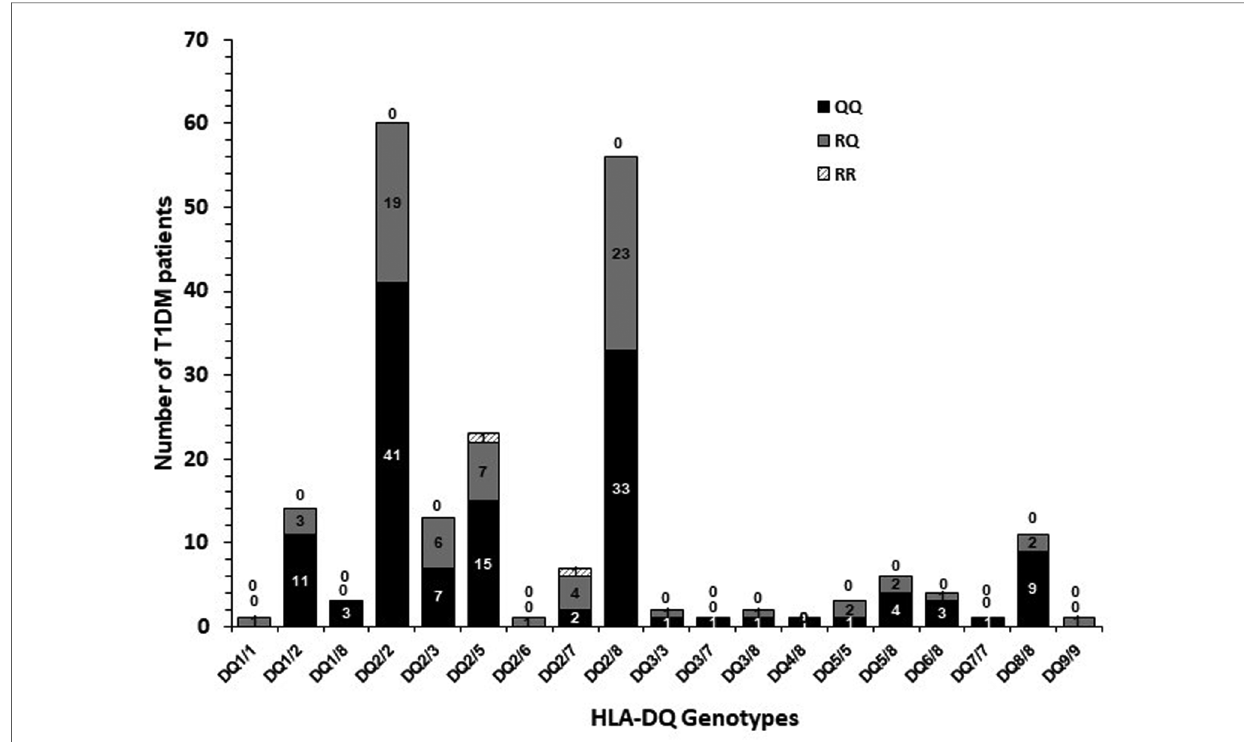
FIGURE 5 Co-inheritance of IL13 gene p .(Arg130Glu; rs20541) polymorphism genotypes with HLA-DQ genotypes in Kuwaiti T1DM patients. “ 0 ” above the bars indicate the absence of a particular genotype. The shaded bars show the co-inheritance with various HLA-DQ genotypes.